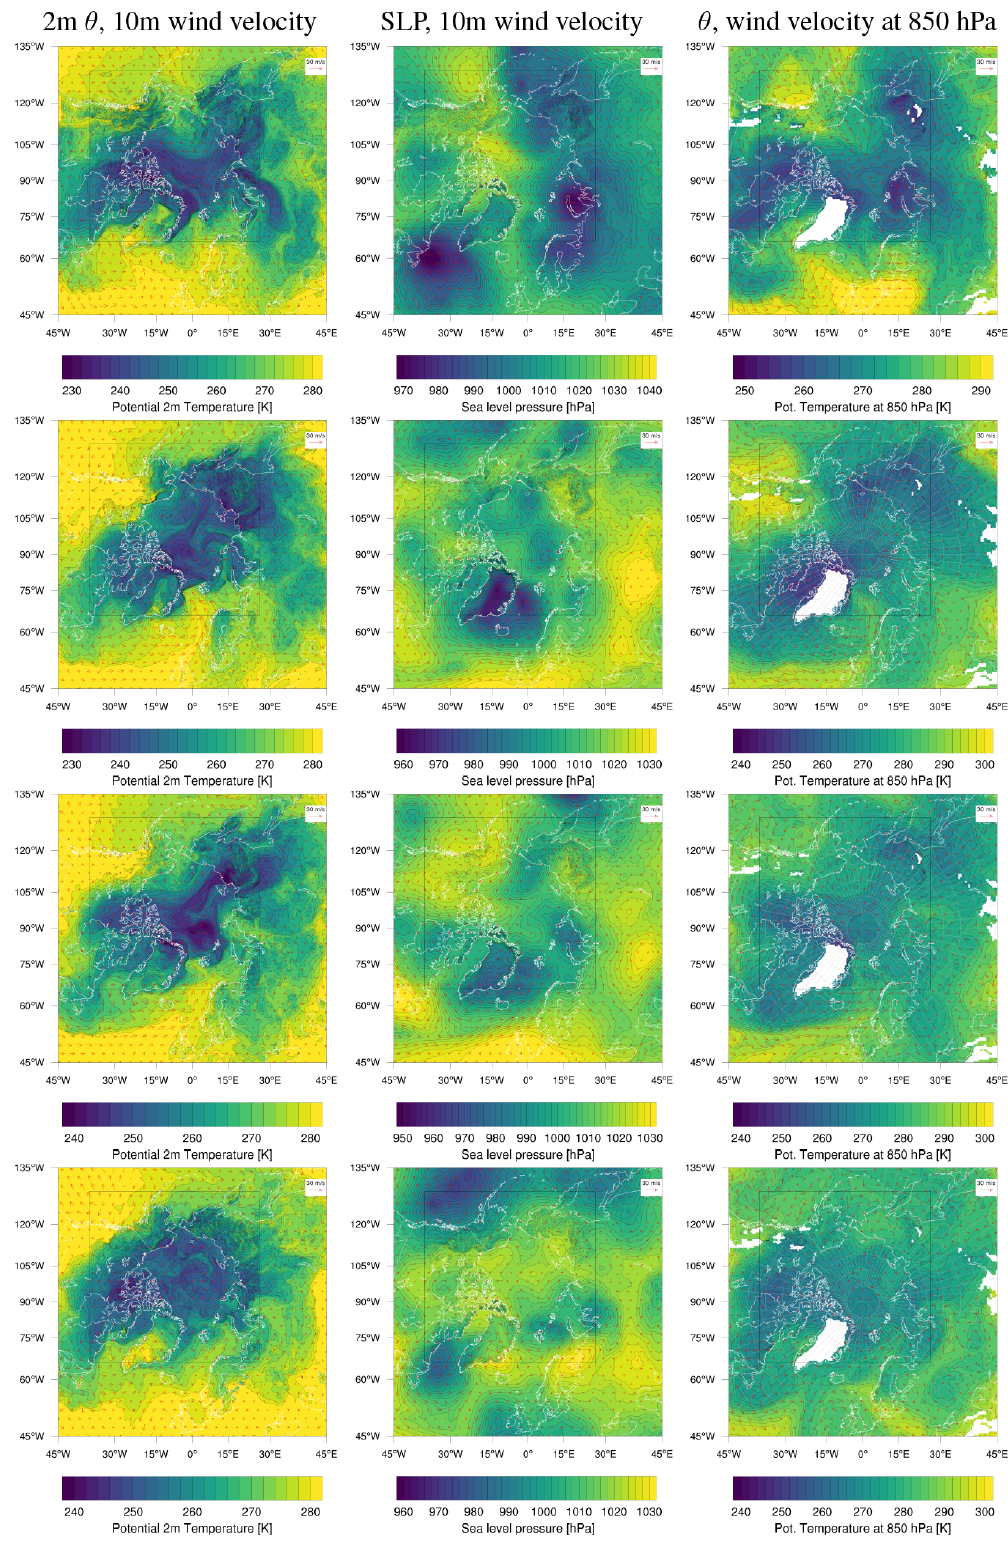
Figure 11. Simulated meteorology in 2019. From top to bottom: 27 February at 18:00GMT; 19 March at 20:00GMT; 27 March at 20:00GMT; 5 April at